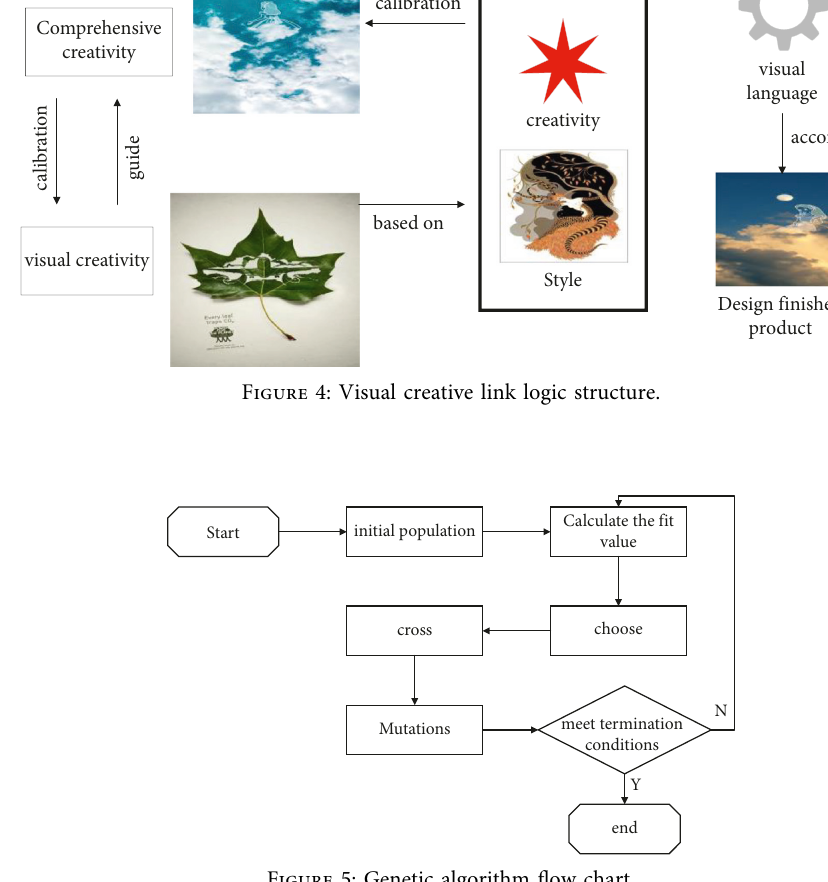
Figure 5: Genetic algorithm flow chart.